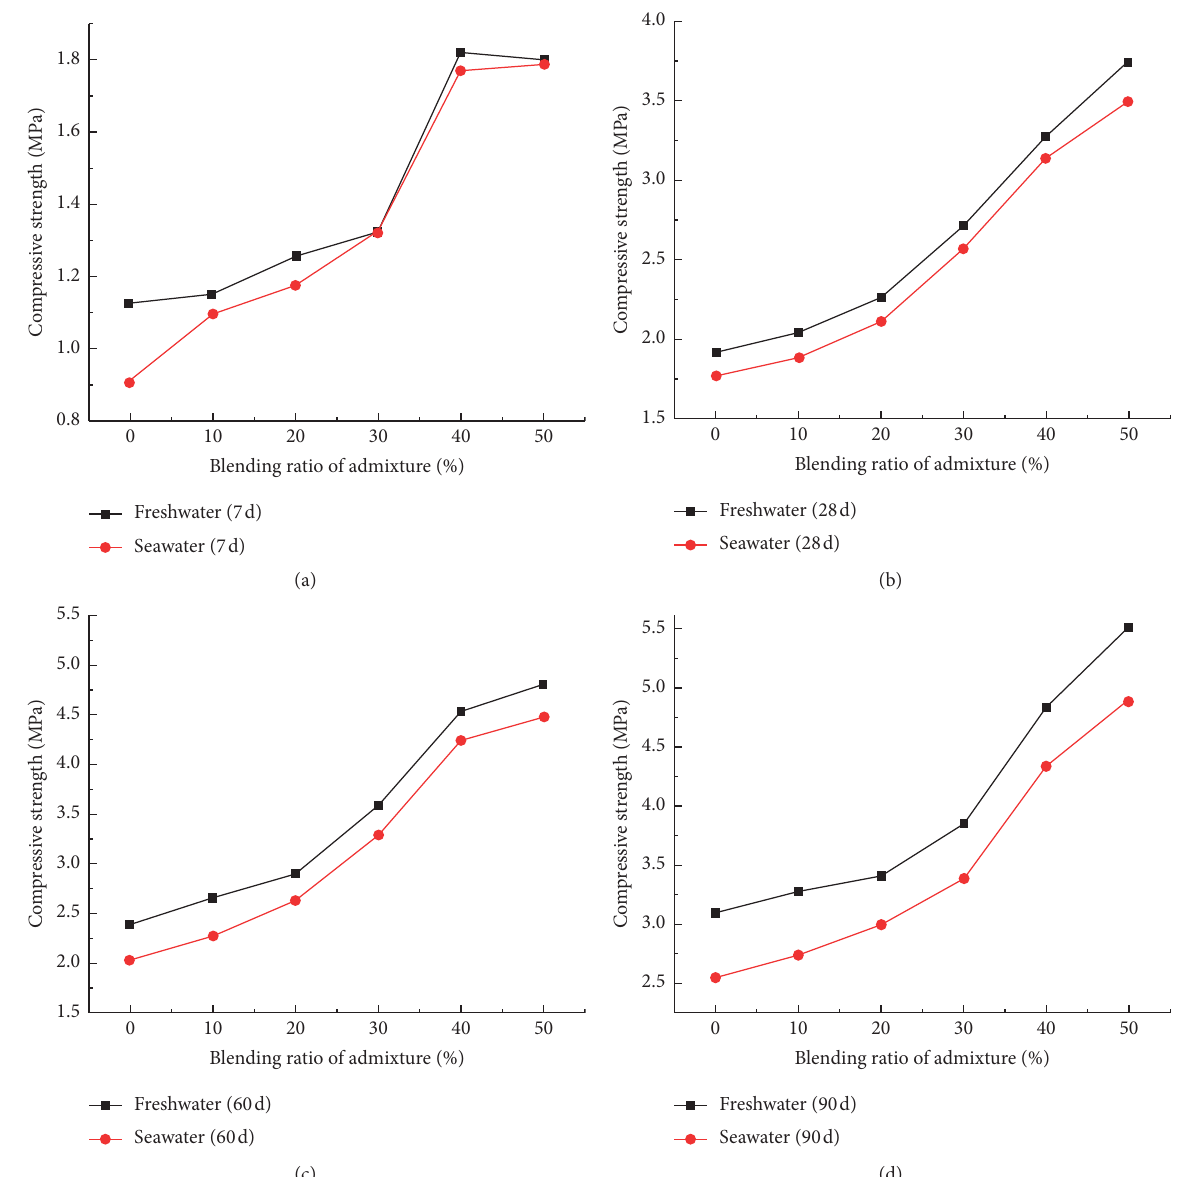
Figure 3: Strength curve of soil-cement in freshwater and marine environment. (a) 7 days. (b) 28 days. (c) 60 days. (d) 90 days. Table 6: Strength growth rate of cement soil. Growth rate